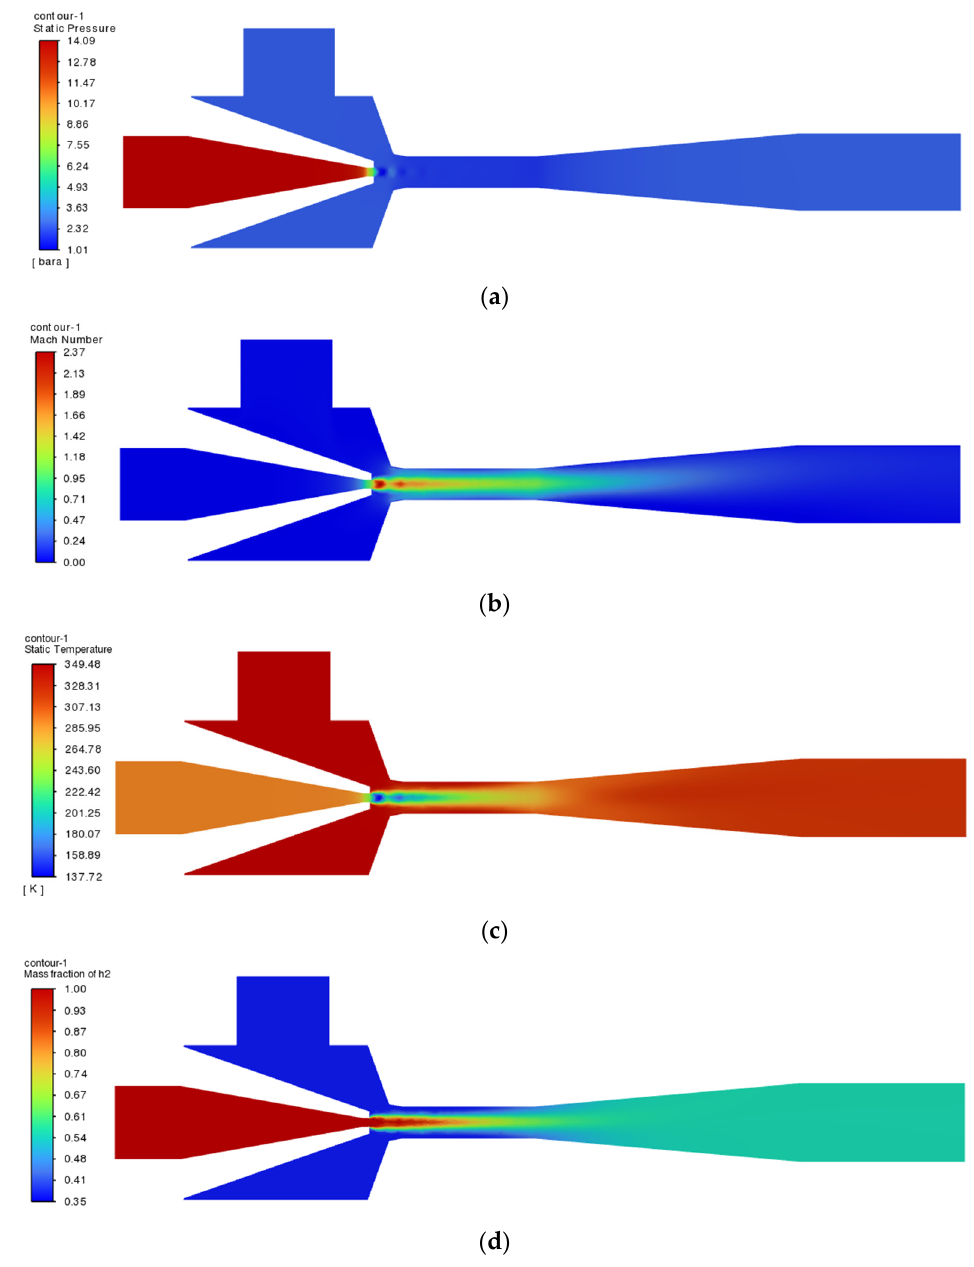
Figure 5. CFD simulation results: ( a ) pressure; ( b ) velocity; ( c ) temperature; ( d ) H 2 mass fraction.